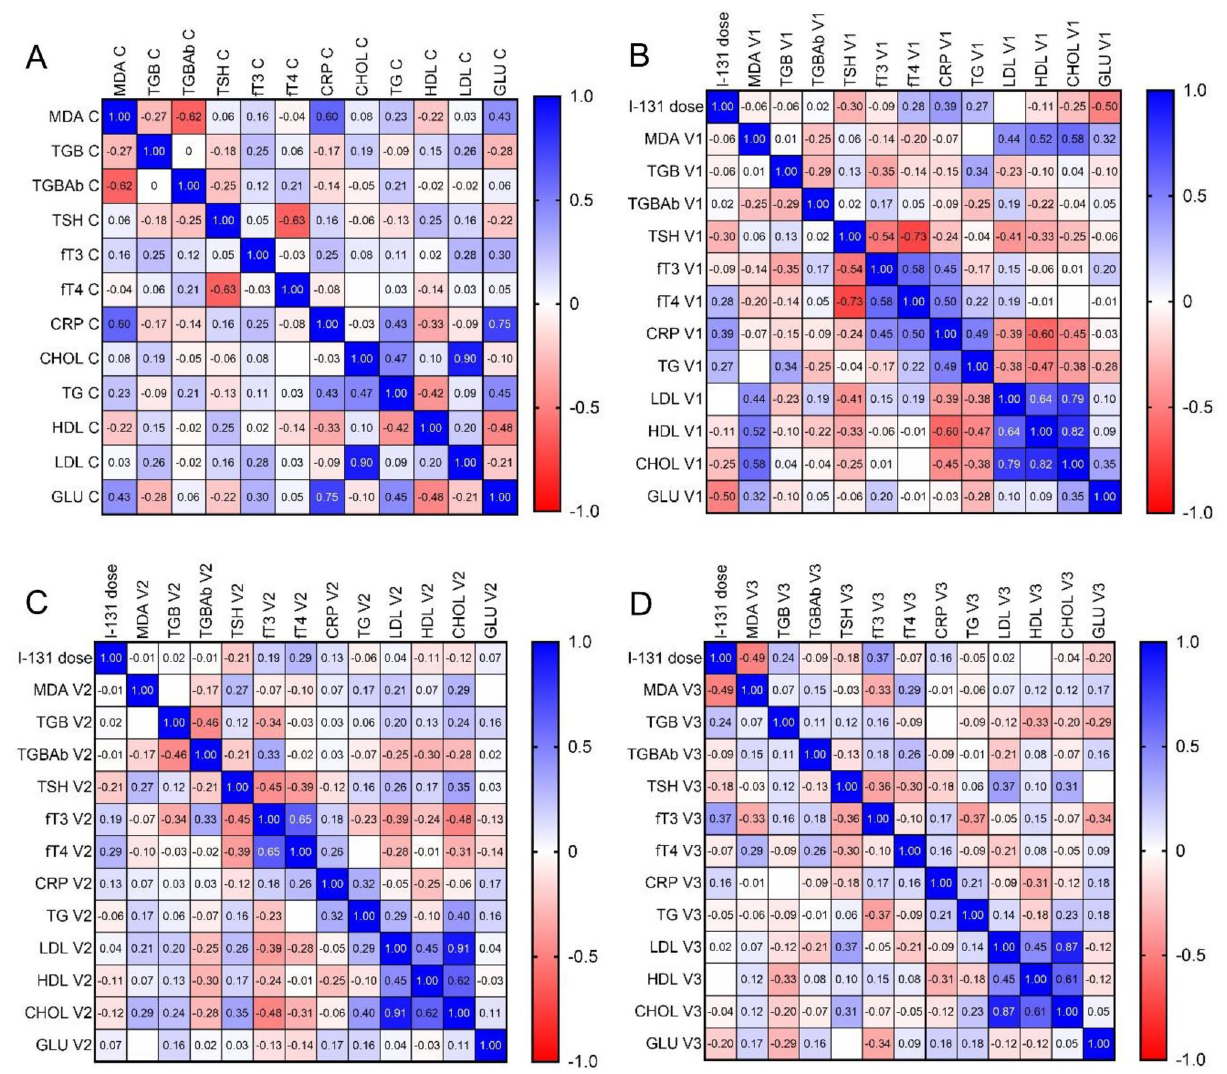
Figure 3. Graphical Spearman’s correlation matrix of the biochemical parameters: ( A ) control group; ( B ) visit 1 (before ablation treatment); ( C ) visit 2 (three days after ablation treatment); ( D ) visit 3 (1 year after ablation treatment); C control group; CHOL cholesterol; CRP C-reactive protein; fT3 free triiodothyronine; fT4 free thyroxine; HDL high-density lipoprotein; LDL low-density lipoprotein; MDA malondialdehyde; TG triglyceride; TGB thyroglobulin; TGBAb thyroglobulin antibodies; TSH thyroid-stimulating hormone; V